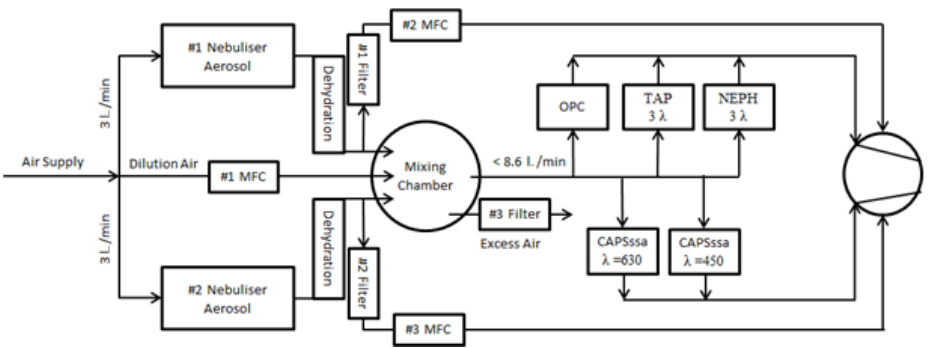
Figure 1. Experimental set-up for the measurements. Flame soot measurements were done with a combustion flame source replacing nebu- lizer no.